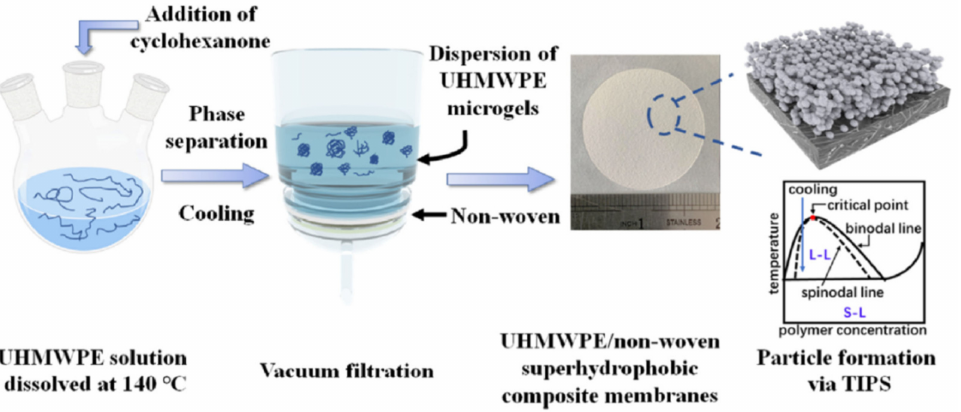
Figure 9. Schematic for preparing superhydrophobic UHMWPE/non-woven composite membranes. Reprinted with permission from J. Quan, J. Yu, Y. Wang, Z. Hu, Journal of Membrane Science, Elsevier, 2022